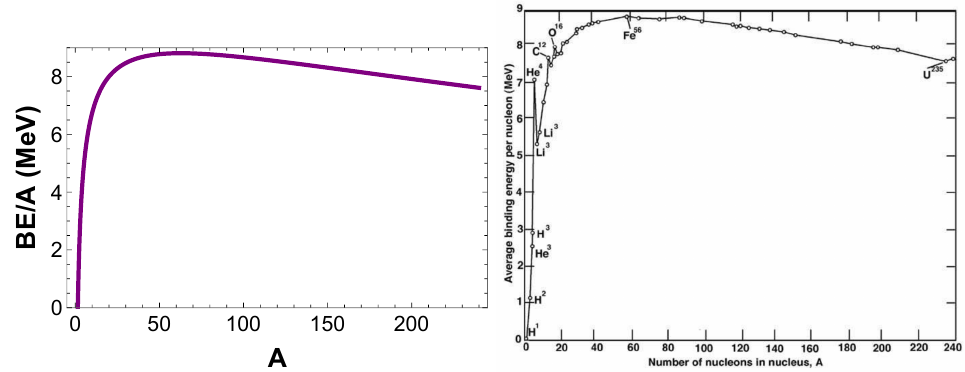
Figure 4: Left: theoretical binding energy per nucleon for most stable configuration, from semi-empirical mass formula; Right: Actual data (courtesy of Xiangdong